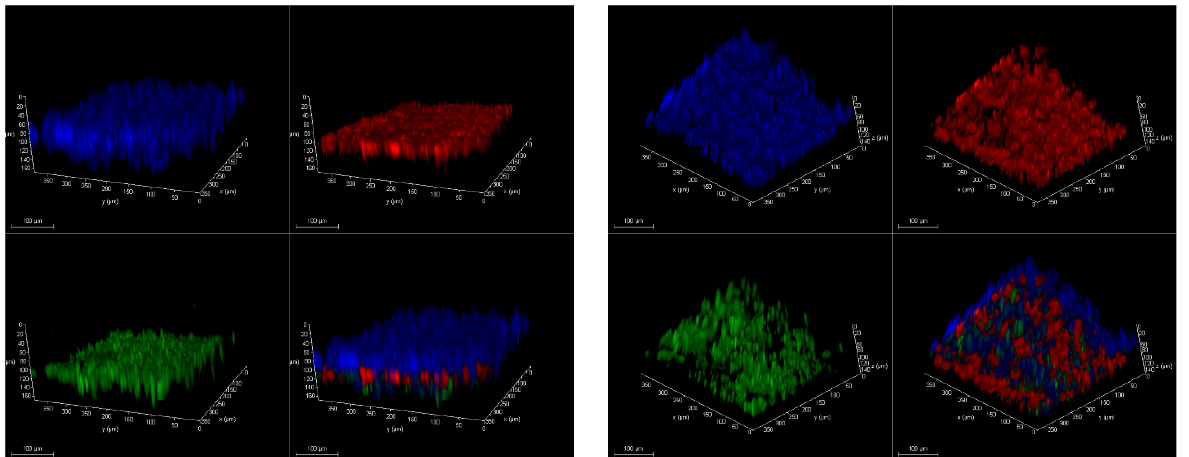
Figure 5. Confocal microscopy of 3D images of HUVEC and A549 cells on both sides of PC membrane in PDMS LOAC device from two different angles. Blue color represents DAPI-stained cell nucleus. The green color represents FITC-stained ZO1 antibody. The red color represents APC-stained CD31 antibody.